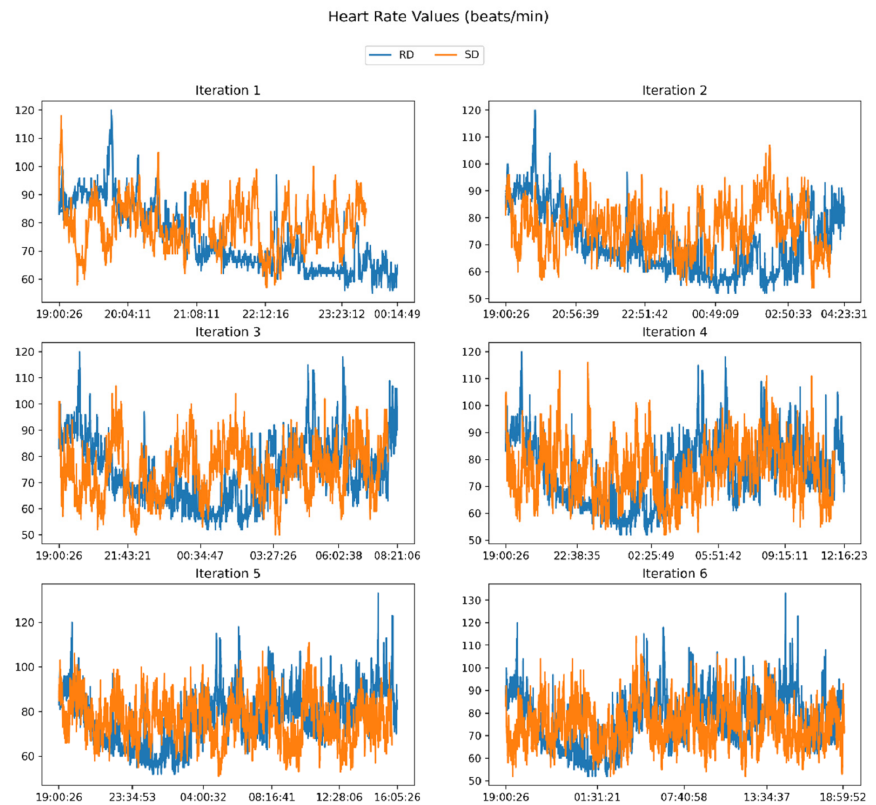
Figure 8. Time plot for visual comparison of RD and SD heart rate measurement values. Each plot corresponds to one iteration of the executed